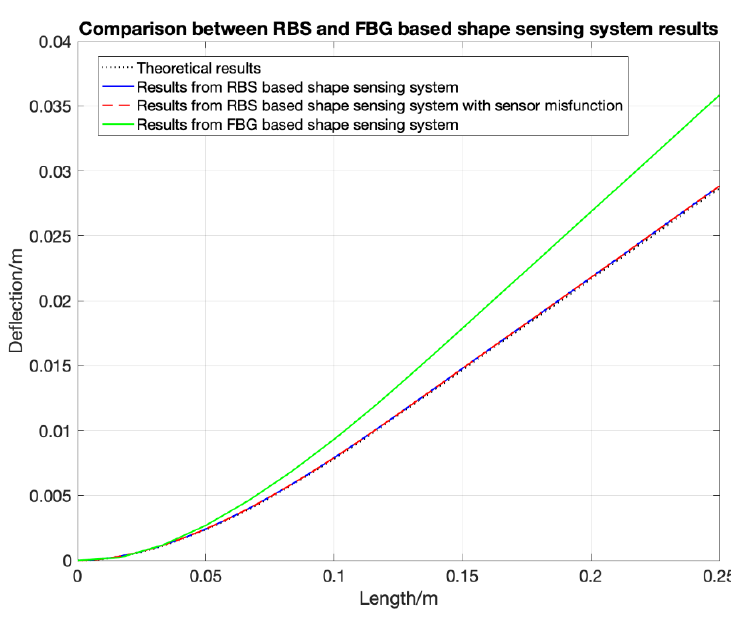
Figure 17. Shape sensing results from the RBS sensor and the FBG sensor.